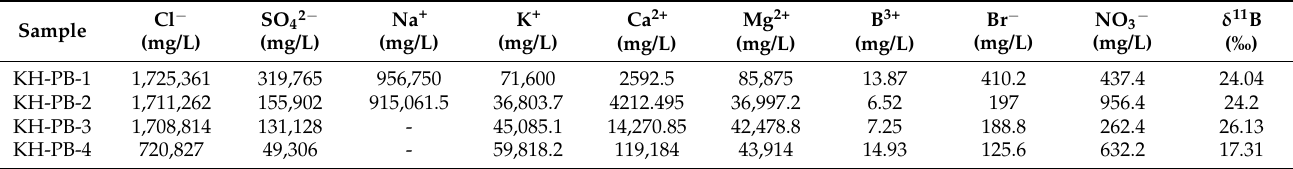
Table 2. δ 11 B values and ionic composition of modern brines (halite dissolved by meteoric water) from the Salt Range